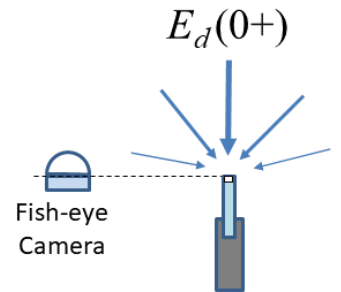
Figure 4. Schematic showing how a fish-eye camera, preferably fully hemispherical, can be used to qualitatively check for the superstructure contamination of 𝐸 𝑑0+ measurements.